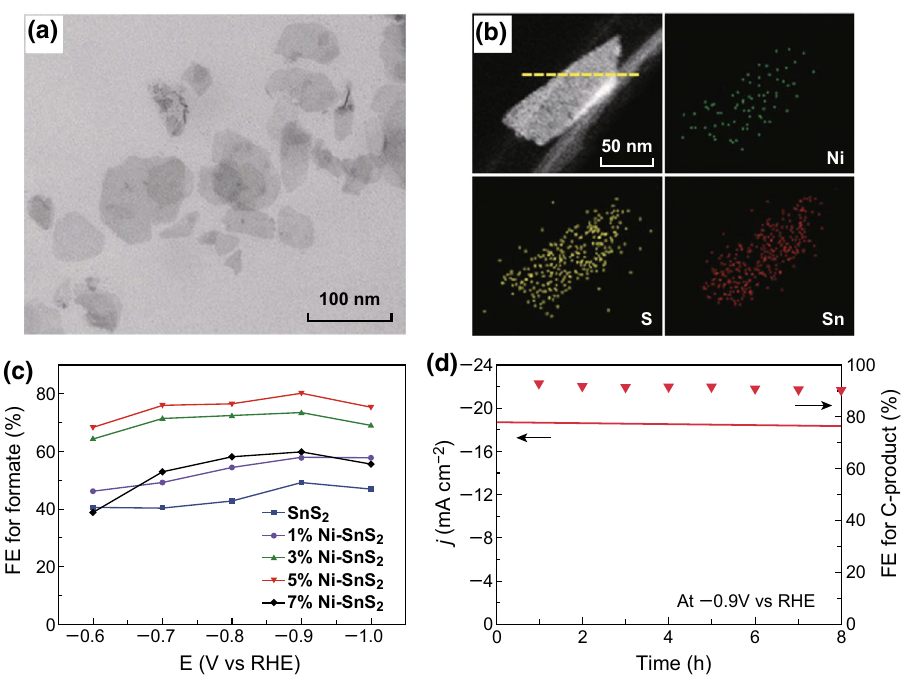
Fig. 9 a TEM image of 5%Ni‑SnS 2 nanosheets. b HAADF‑STEM and STEM‑EDS elemental mapping images of individual 5%Ni‑SnS 2 nanosheets. c FEs for formate production over pristine SnS 2 and Ni‑doped SnS 2 nanosheets. d Long‑term stability performance of 5%Ni‑SnS 2 nanosheets at − 0.9 V (vs. RHE) for 8 h. Reprinted with permission from Ref.